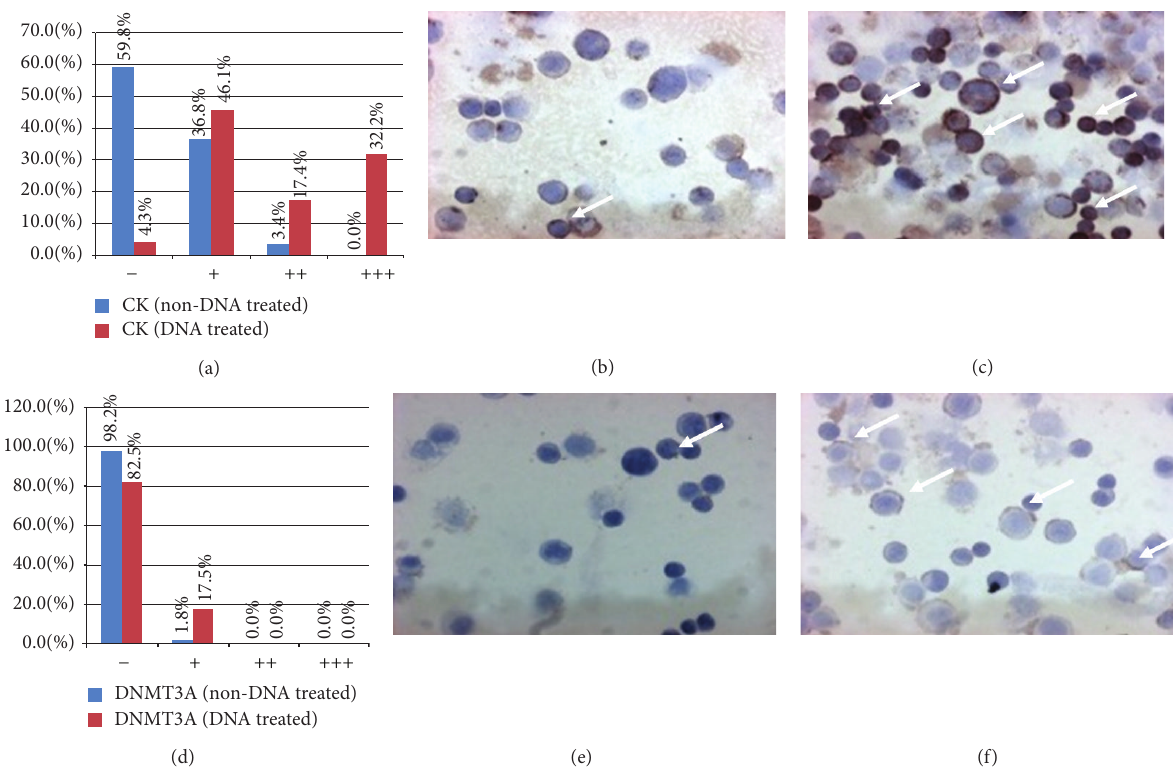
Figure 3: Distribution of cytokeratine (CK; (a)–(c)) and DNA methyltransferase 3A (DNMT3A; (d)–(f)) immunoreactive HT29 cells. (a) and (d) 𝑥 -axes represent the intensities of immunoreactions from negative ( − ) to strong (+++). 𝑦 -axes represent the distribution (percentage) of cells showing different immunoreaction intensities (blue columns: control cells; red columns: type 3. DNA-treated cells). (b) and (c) CK expression before (b) and after (c) type 3. DNA incubation (immunoreactive cells/arrows/display brownish cytoplasmic reaction, 200x magnification, hematoxylin costaining). (e) and (f) DNMT3A expression before (e) and after (f) type 3. DNA incubation (immunoreactive